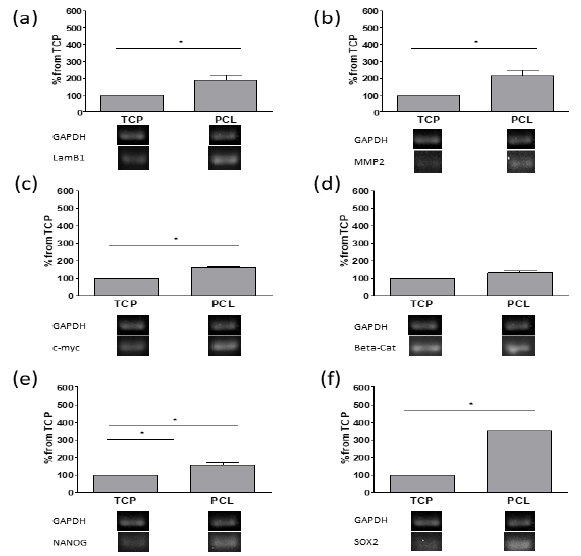
Figure 5. RT-PCR analysis of LamB1 ( a ), MMP2 ( b ), c-myc ( c ), β -cat ( d ), NANOG ( e ), and SOX2 ( f ) of cultures grown on tissue-culture polystyrene (TCP), and PCL scaffolds at 7 days from seeding. Quantification of transcript levels was carried out by densitometric analysis using ImageLab software. Data were reported as percentage from TCP taken as 100. * p < 0.05 vs. TCP cultures; Student’s t test.